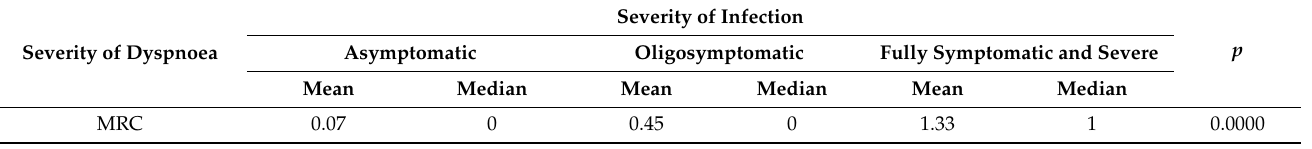
Figure 1. Dyspnoea level of subjects who underwent SARS-CoV-2 virus infection.